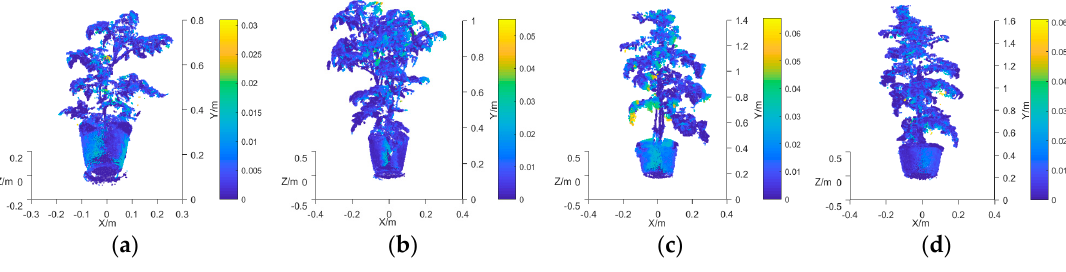
Figure 6. H RS sets of the GTPs: ( a ) GTP T25; ( b ) GTP T29; ( c ) GTP T48; ( d ) GTP T56.